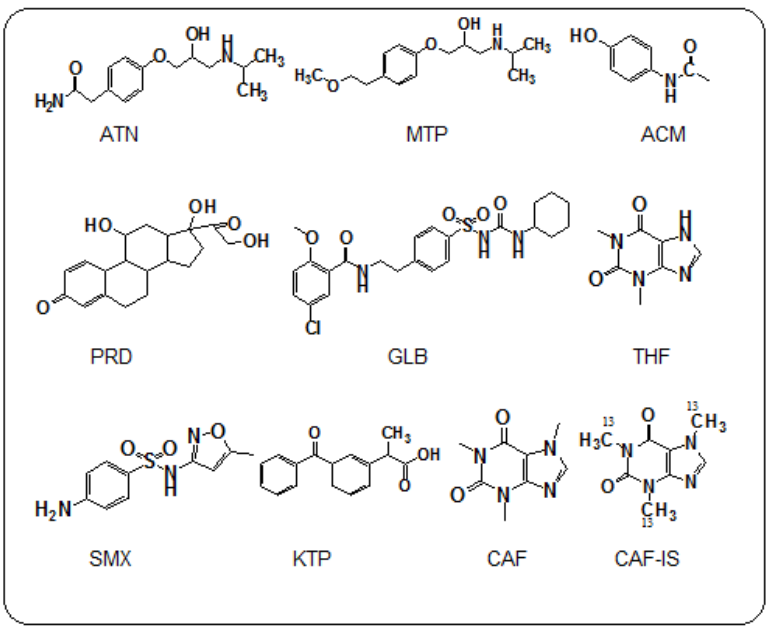
Figure 1. Chemical structures of the studied pharmaceuticals.